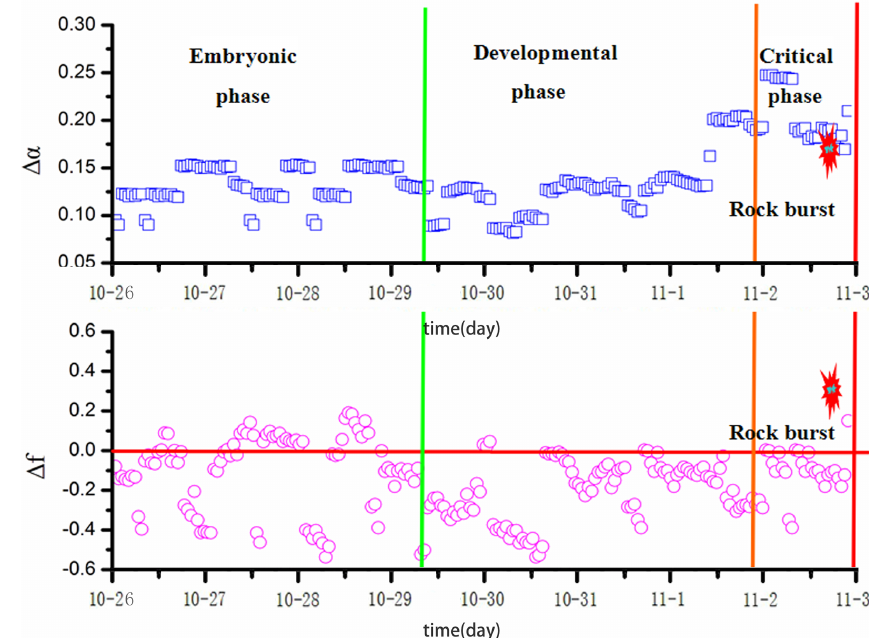
Figure 9. Temporal multifractal spectrum of EMR in the bolted roadway of the heading face of Coal Mine B.